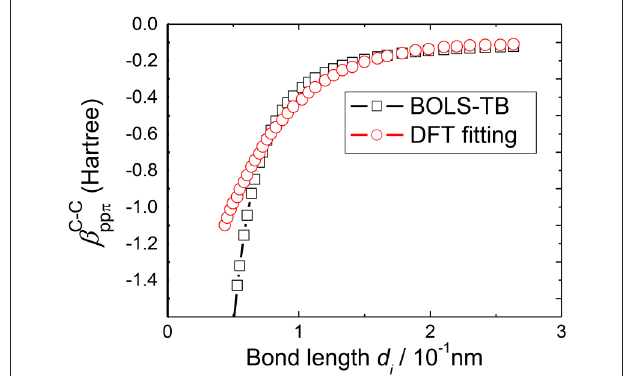
FIGURE 3 | Correlation between the β ij and the bond length d derived by BOLS–TB compared with previous TB fitting from the DFT results